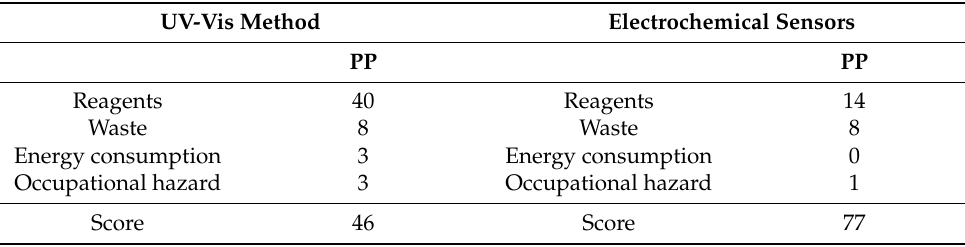
Table 4. Total score and penalty points (PP) of the analytical methods evaluated after the application of the Analytical Eco-Scale. UV-Vis Method